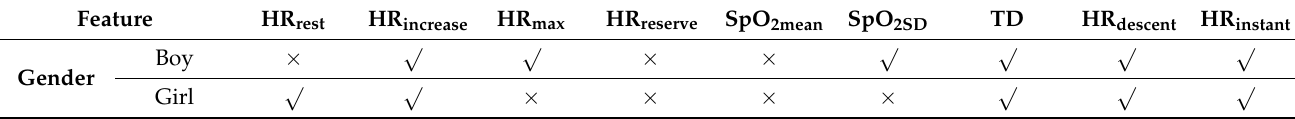
Table 5. Final selected feature set. ‘ ‘ × ’ means the